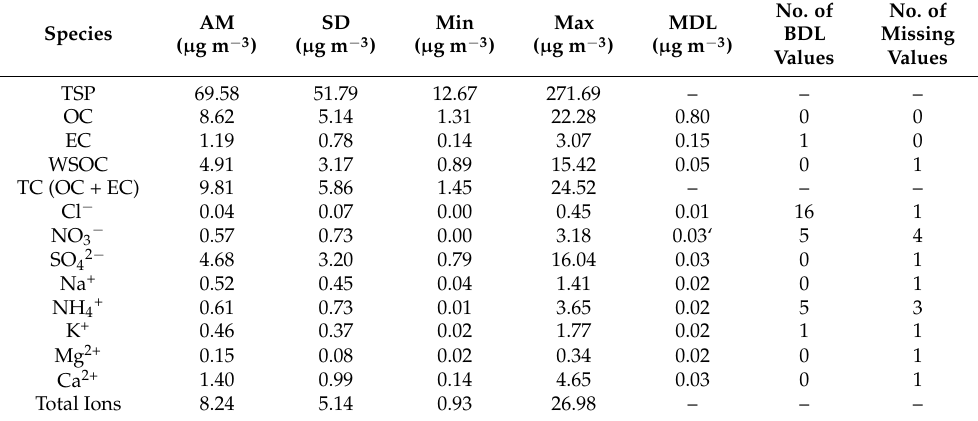
Table 1. The arithmetic mean (AM), standard deviation (SD), range (minimum and maximum) of concentrations, and method detection limits (MDL) for TSP, OC, EC, WSOC, and WSIS. The number of samples with chemical species below detection limits and the number of missing values are also